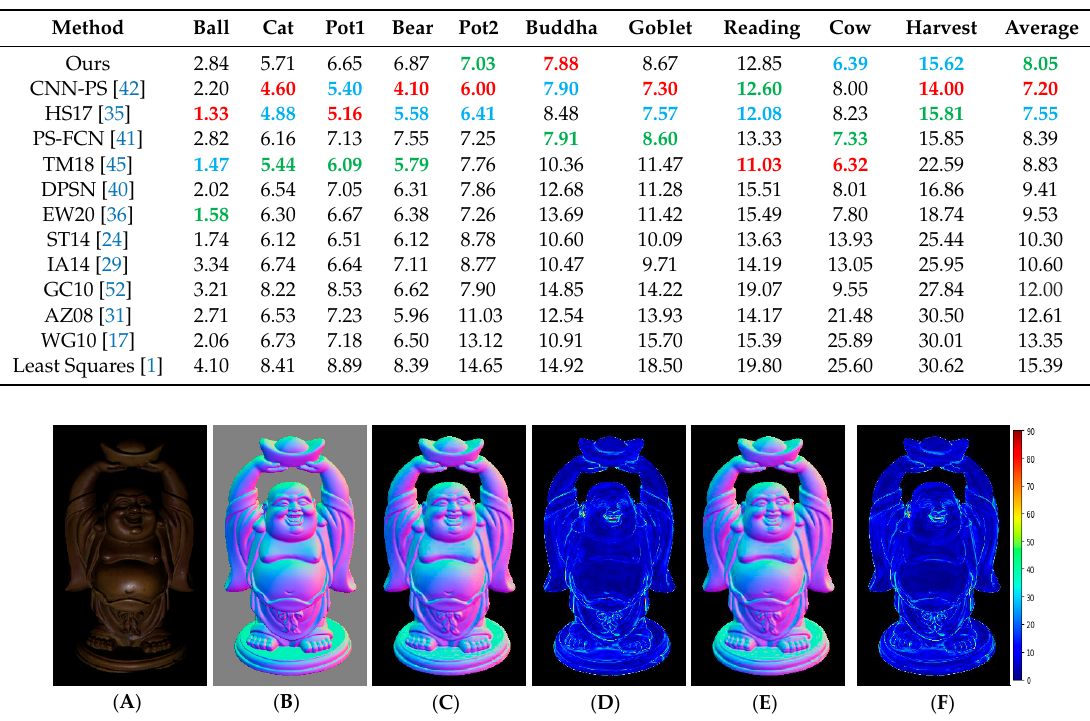
Figure 4. Visual quality comparisons on the Buddha object in the DiLiGent benchmark for the calibrated photometric stereo: ( A ) one image among 96 input images; ( B ) ground-truth surface normal map; ( C ) surface normal map estimated with PS-FCN; ( D ) angular error map for PS-FCN; ( E ) surface normal map estimated with the proposed method; ( F ) angular error map for the proposed method. For the uncalibrated photometric stereo experiment, the predicted surface normal with the proposed method and SDPS-Net achieved average MAEs of 9.07 ° and 9.51 ° , respectively. In addition, the results of the proposed method showed that the prediction accuracy was improved over the SDPS-Net in nine out of ten objects in the DiLiGent dataset, as seen in Table 2. Figure 5 shows visual comparisons with the Harvest object of the DiLiGenT benchmark for the SDPS-Net and the proposed uncalibrated photometric stereo method where (A) shows one image among input images, (B) shows the color-encoded map of ground-truth surface normals, (C) and (E) show a color-encoded surface normal map for SDPS-Net and the proposed method, respectively, (D) and (F) show an angular error map of surface normals estimated with SDPS-Net and the proposed method, respectively. Please refer to Figure S2 for more results.